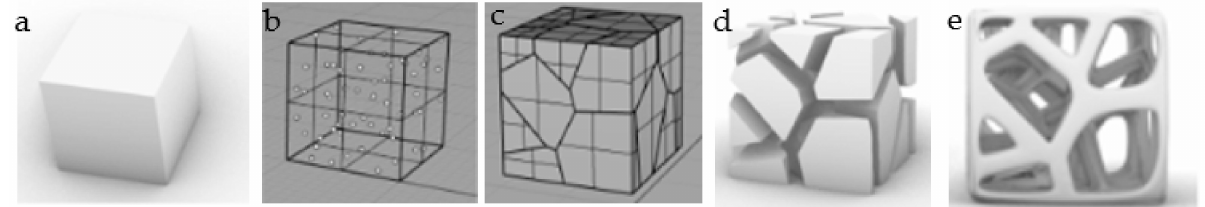
Figure 3. Structure design steps: ( a ) Step 1, assume the cuboid as the design space; ( b ) Step 2, randomly generate n discrete points in the cuboid; ( c ) Step 3, take discrete points as the core to generate Voronoi polyhedrons with common edges; ( d , e ) Step 4, get the beam structure through Boolean